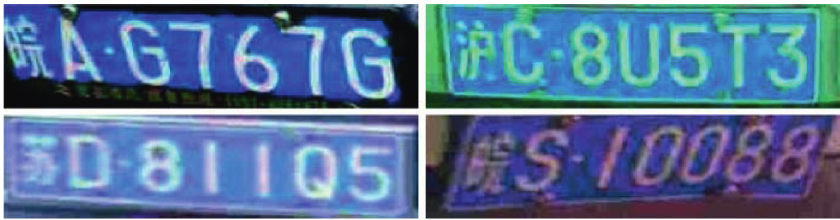
Figure 15: License plate images after cutting and adjusting